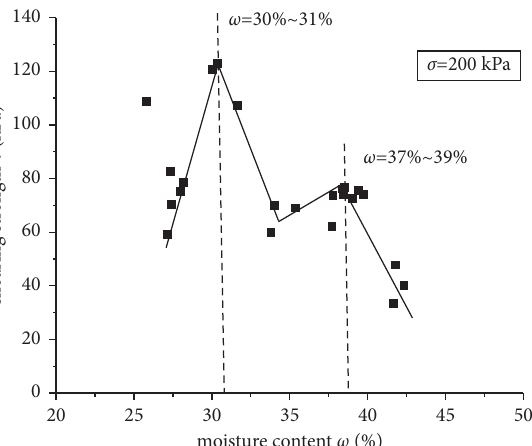
Figure 4: c - w curve.